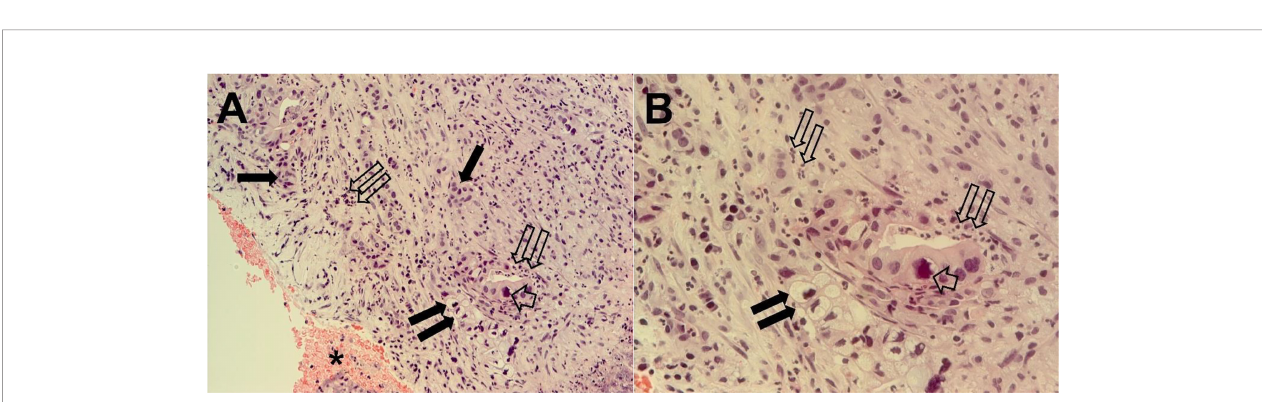
FIGURE 2 | Tumor pancreatic tissue section from ecoendoscopy and needle biopsy cyto included. Tumor cells are organized in differentiated adenomorphic structures or in more poorly differentiated cords, embedded in abundant stroma that are rich in in fl ammatory cells. Necrotic areas are also evident. Single thin arrows, clusters of tumor cells; short broad arrow, a large nucleus; twin open arrows, in fl ammatory cells; twin fi lled arrows, cord of mucous cells with large vacuole and hyperchromic nucleus. The same microscopy fi eld is shown at magni fi cations of ×200 (A) and ×400 (B) .